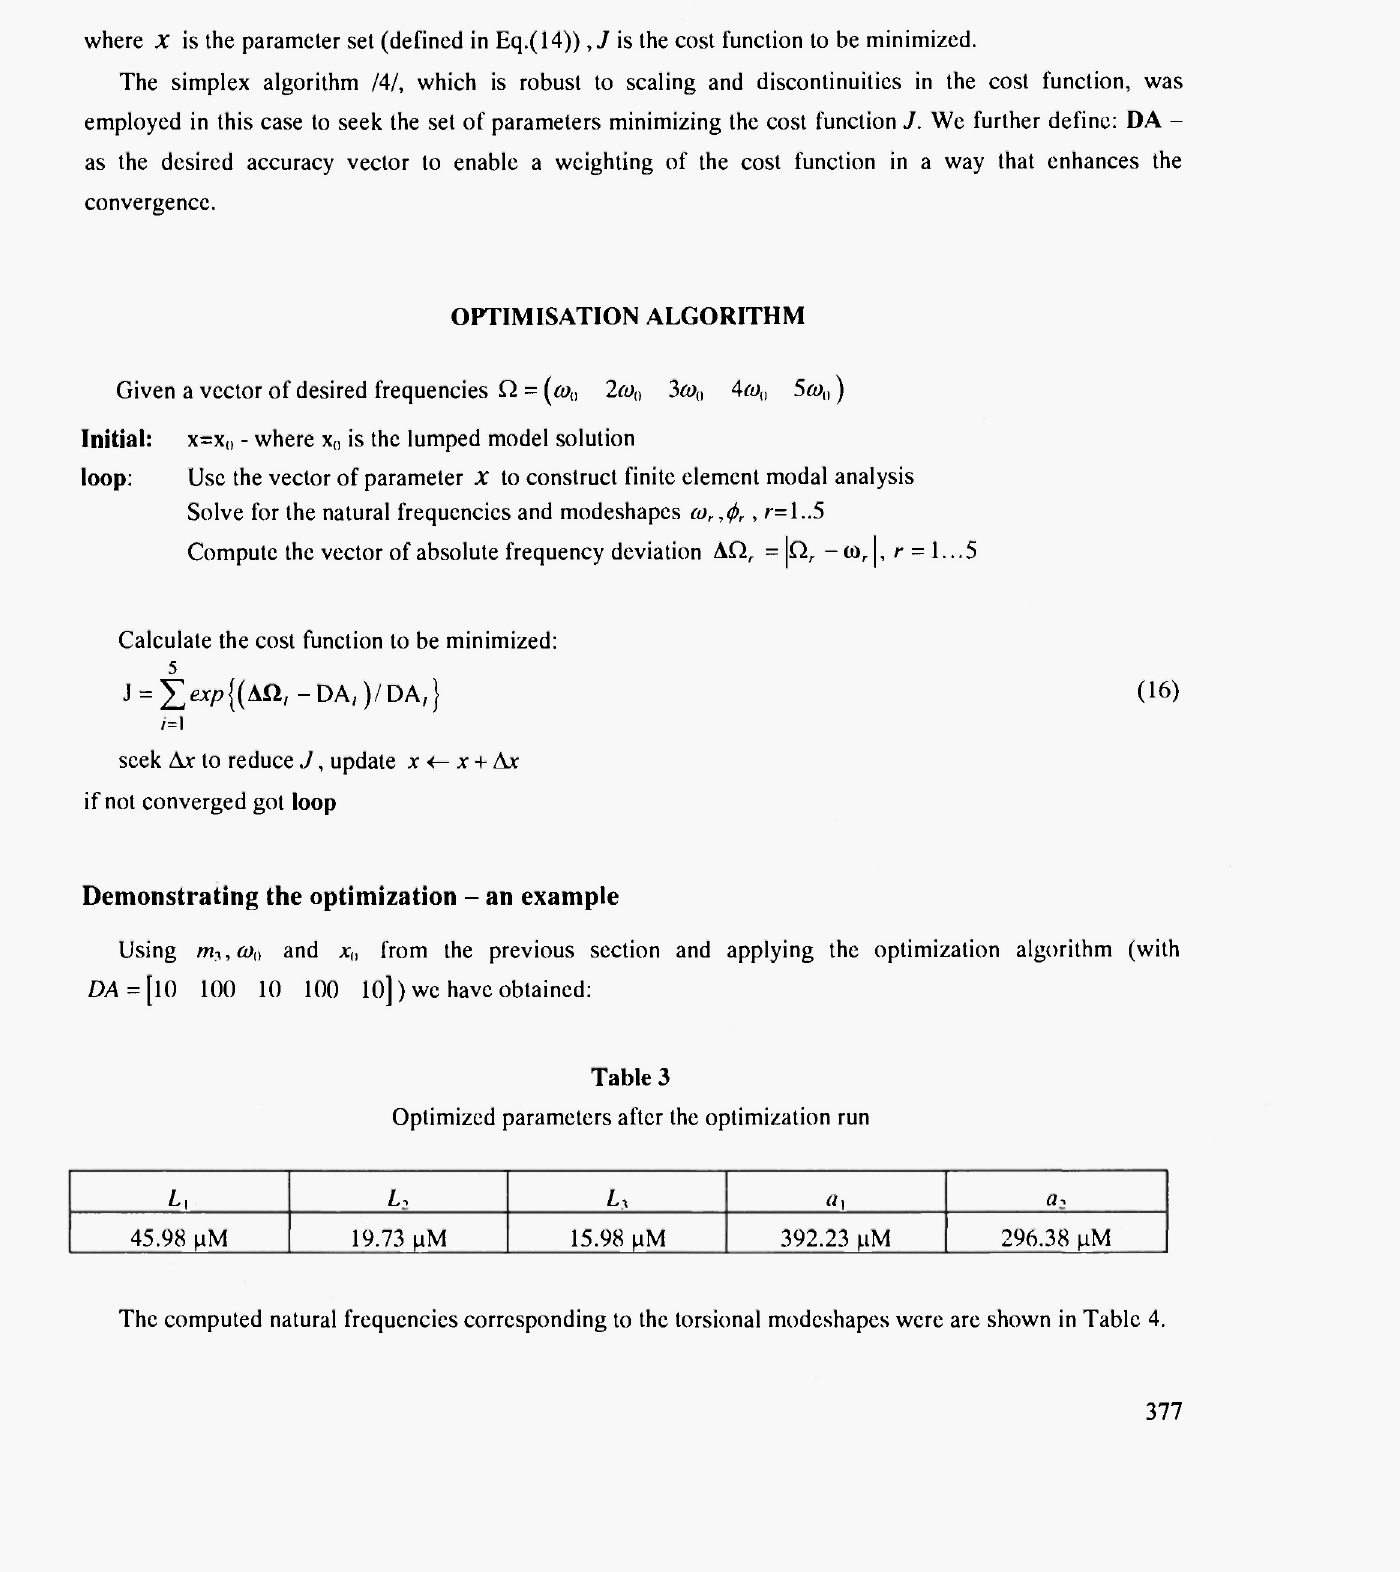
Optimized parameters after the optimization